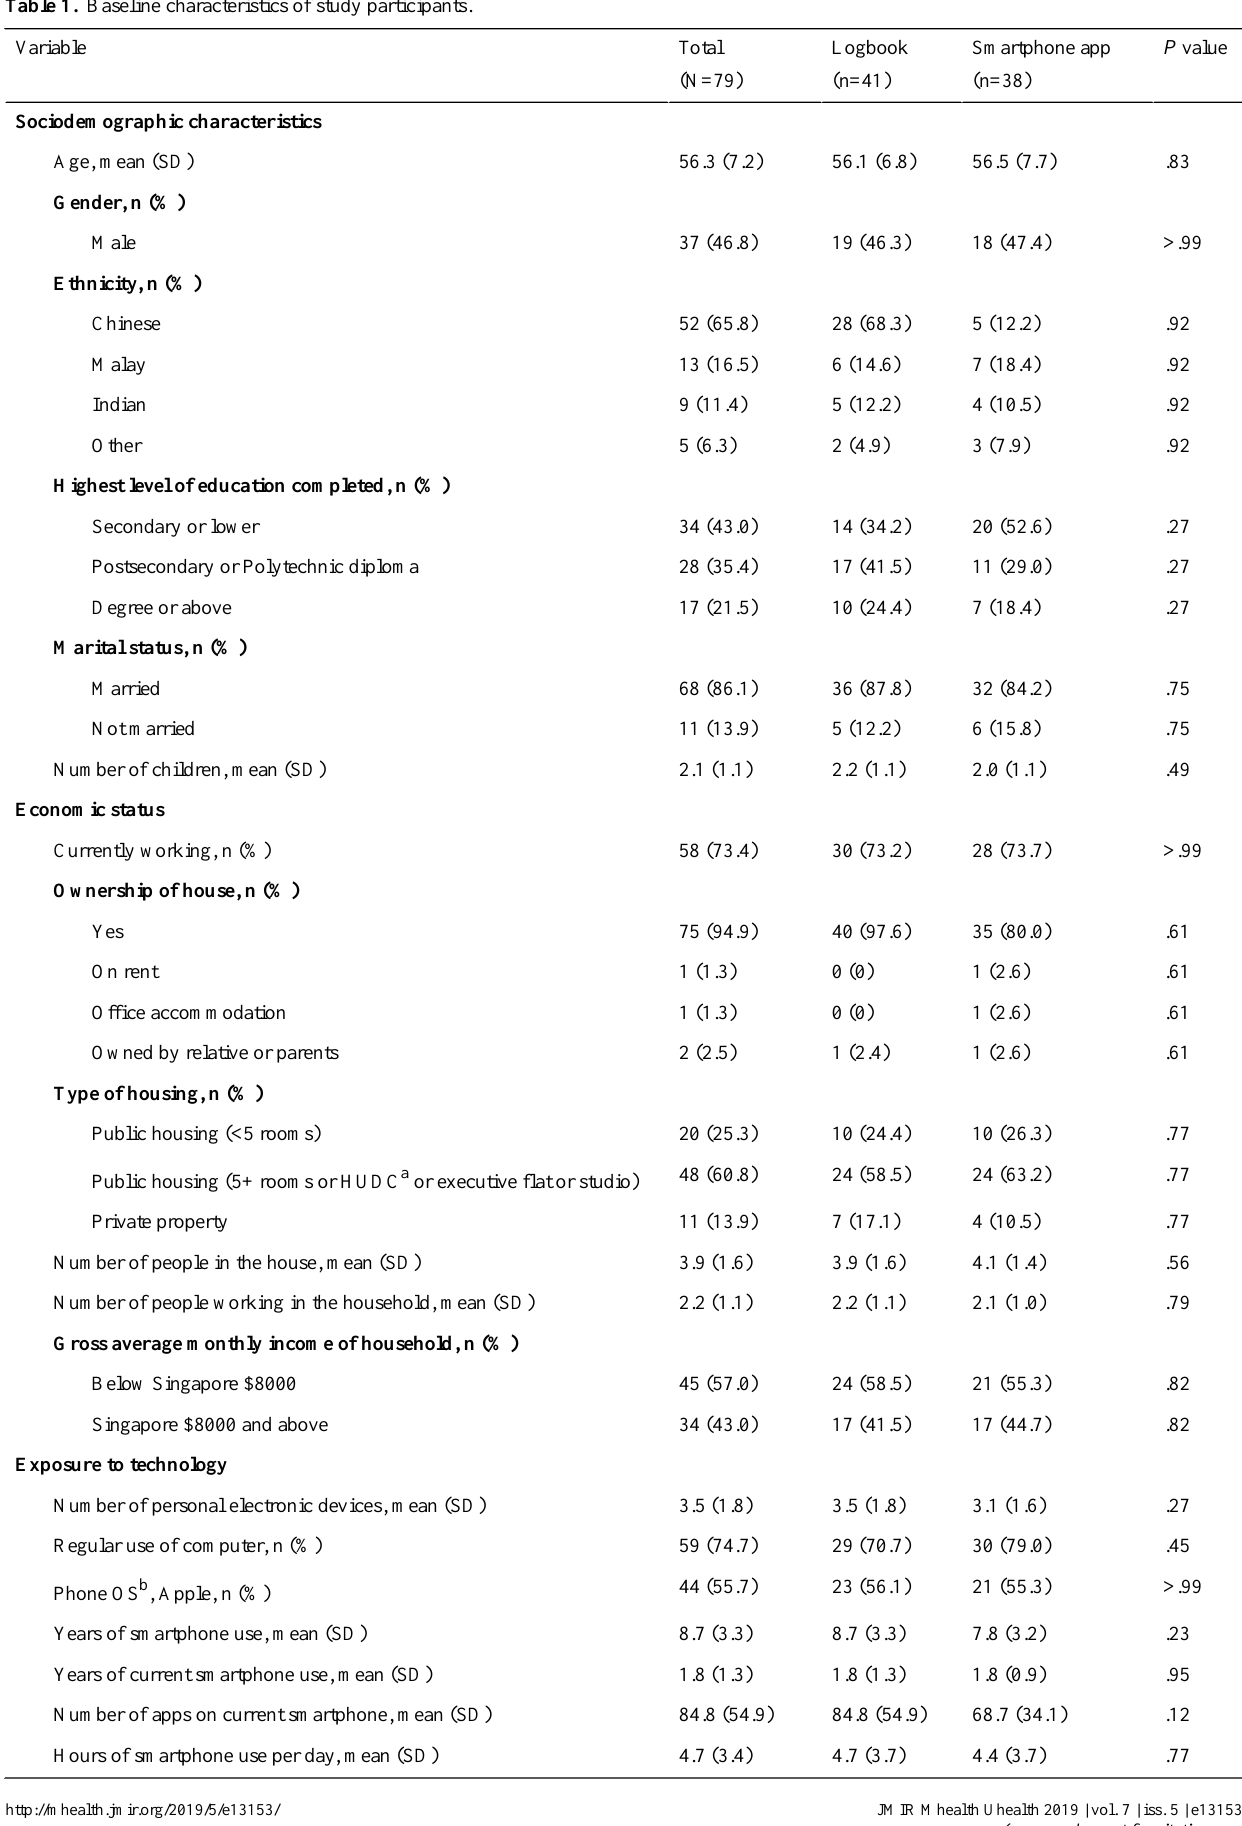
Table 1. Baseline characteristics of study